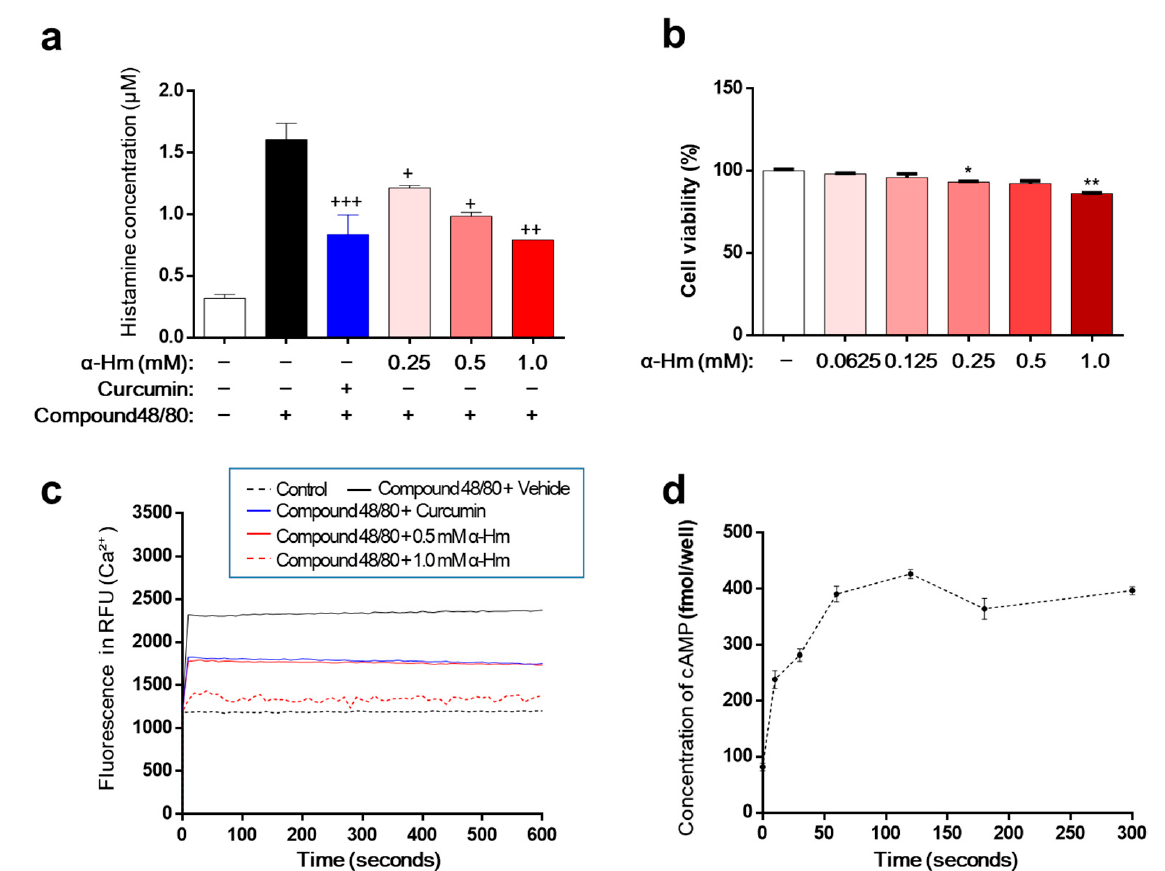
Figure 4. α -Humulene inhibits histamine release in HMC-1 cells. ( a ) Effect of α -humulene ( α -Hm) on histamine release in compound 48/80-treated HMC-1 cells. HMC-1 cells were pre-incubated with α -humulene for 2 h and then stimulated with 5 µ g/ml compound 48/80. Histamine levels in the conditioned medium were measured by spectrofluorimetry. Curcumin (50 µ M) was used as a positive control. ( b ) Graphs showing cell viability using the MTS assay. ( c ) Effect of α -humulene on intracellular calcium influx in HMC-1 cells. ( d ) Effect of α -humulene on intracellular cyclic adenosine monophosphate (cAMP) levels in HMC-1 cells. + p < 0.05, ++ p < 0.01, +++ p < 0.001, * p < 0.05, ** p < 0.01.